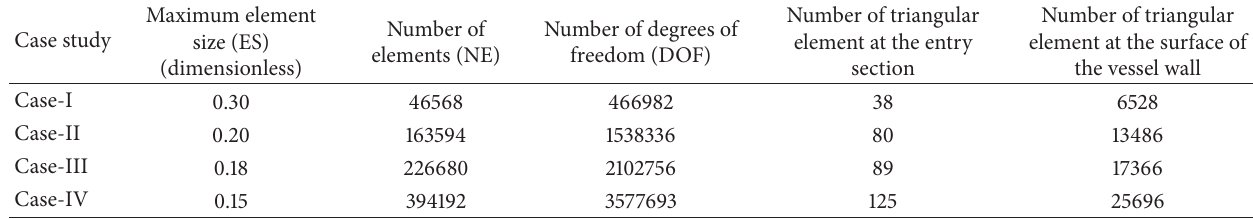
Table 2: Mesh statistics studied in four different cases for a quarter part of the tube.